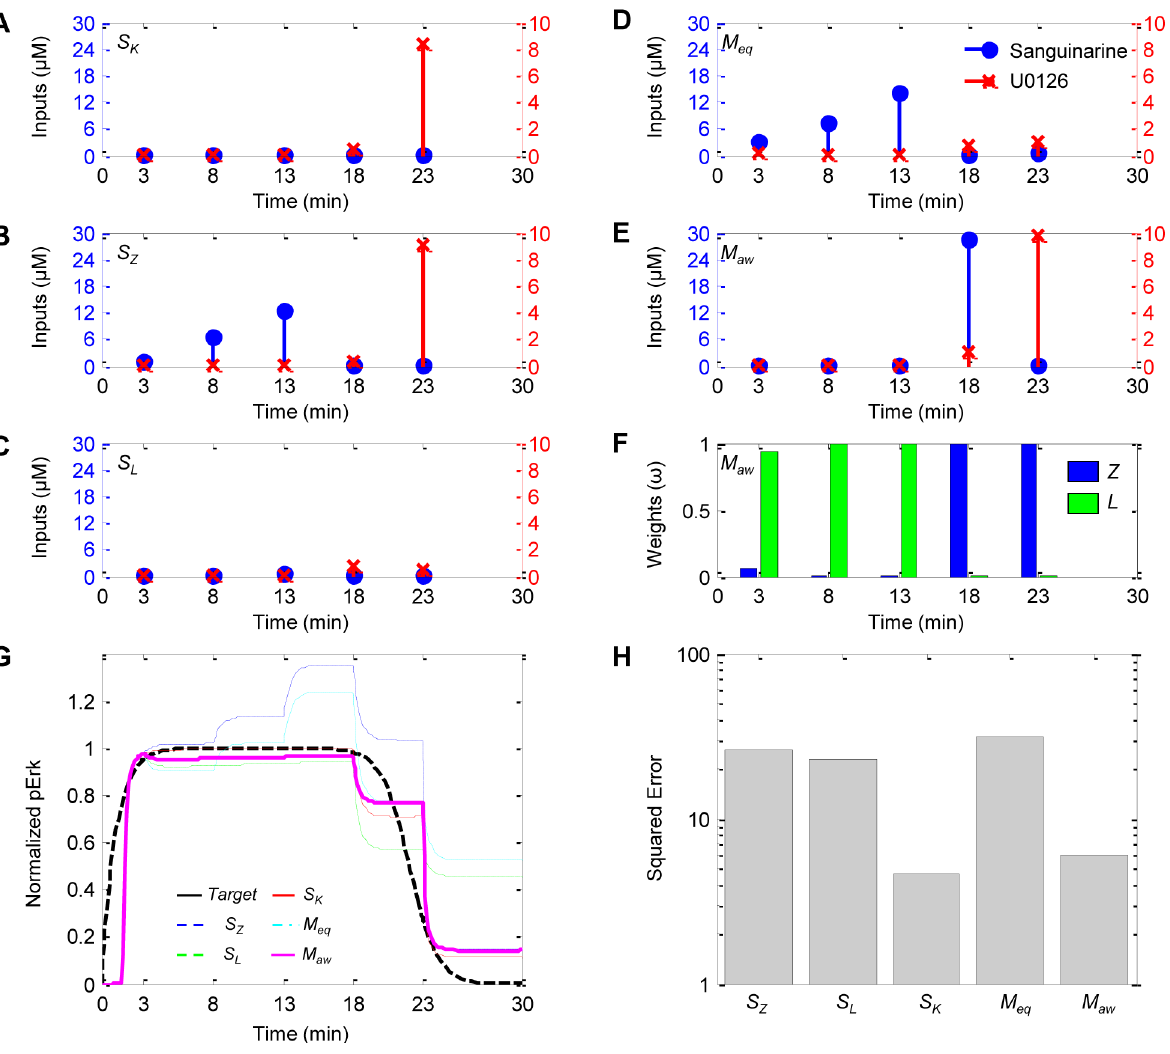
Figure 3. Simulations indicate adaptive weighting strategy significantly improves overall target tracking performance. ( A – E ) Control input dosing regimens for the matched ( S K ) and mismatched ( S Z and S L ) single-model controllers and the multiple-model controllers with fixed equal weights ( M eq ) and with adaptive Akaike weights ( M aw ). ( F ) Akaike weights for M aw . ( G ) Target trajectory (solid black) and simulated system (Model K ) responses controlled by S K (dashed red), S Z (dotted blue), S L (dotted green), M eq (dashed cyan) and M aw (solid magenta). ( H ) The squared error values for all five controllers.